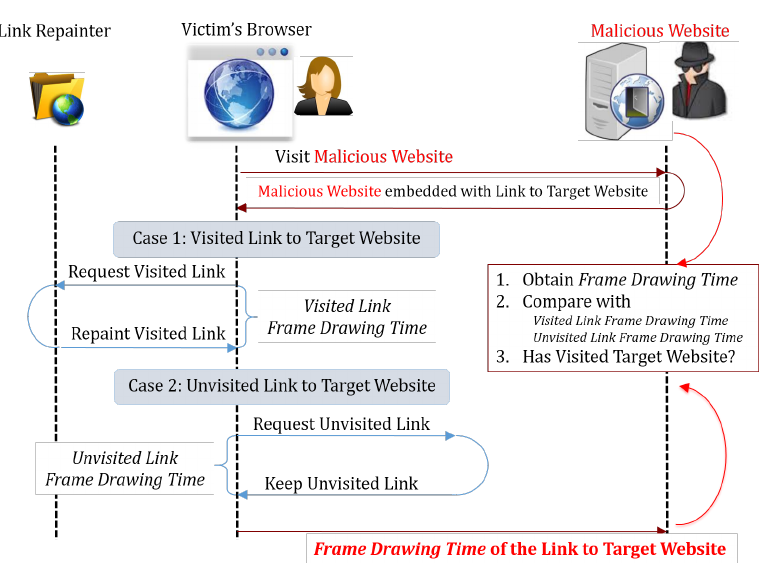
Figure 10. Repainting-based timing probing attack.